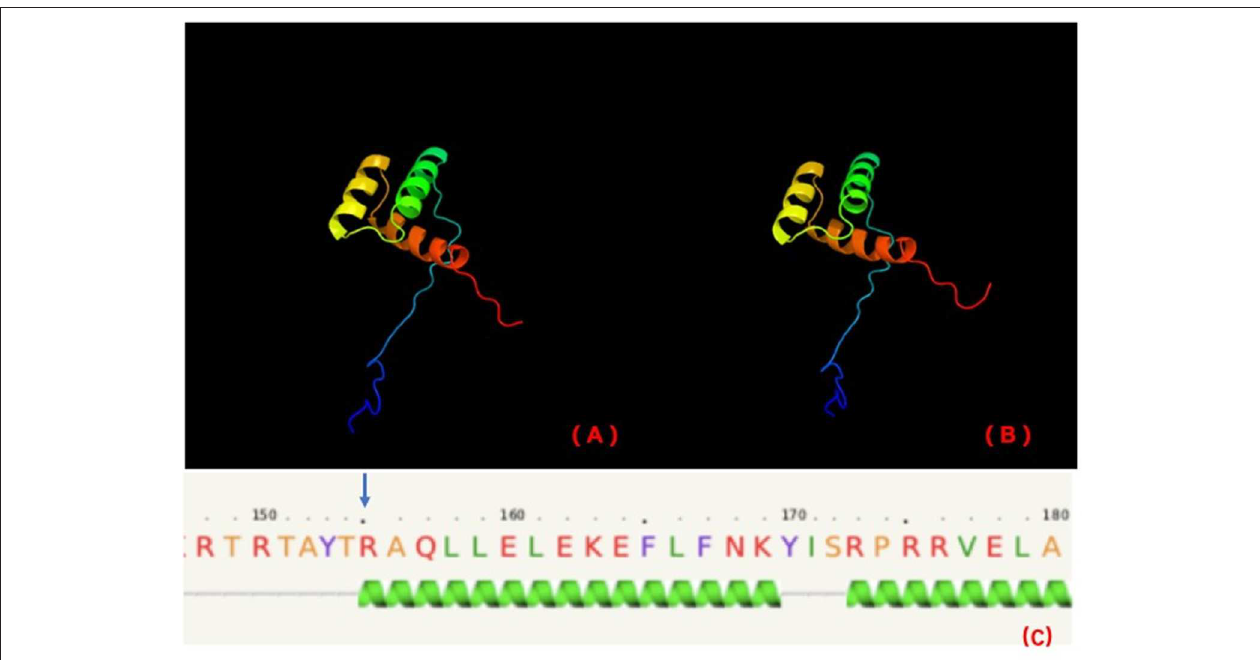
FIGURE 3 | PHYRE2 predicts no difference in the structure of wild-type (A) and mutation (B) . The 155th amino acid (blue arrow) is predicted to be in the first helix of IPF1 of wild-type (C) .